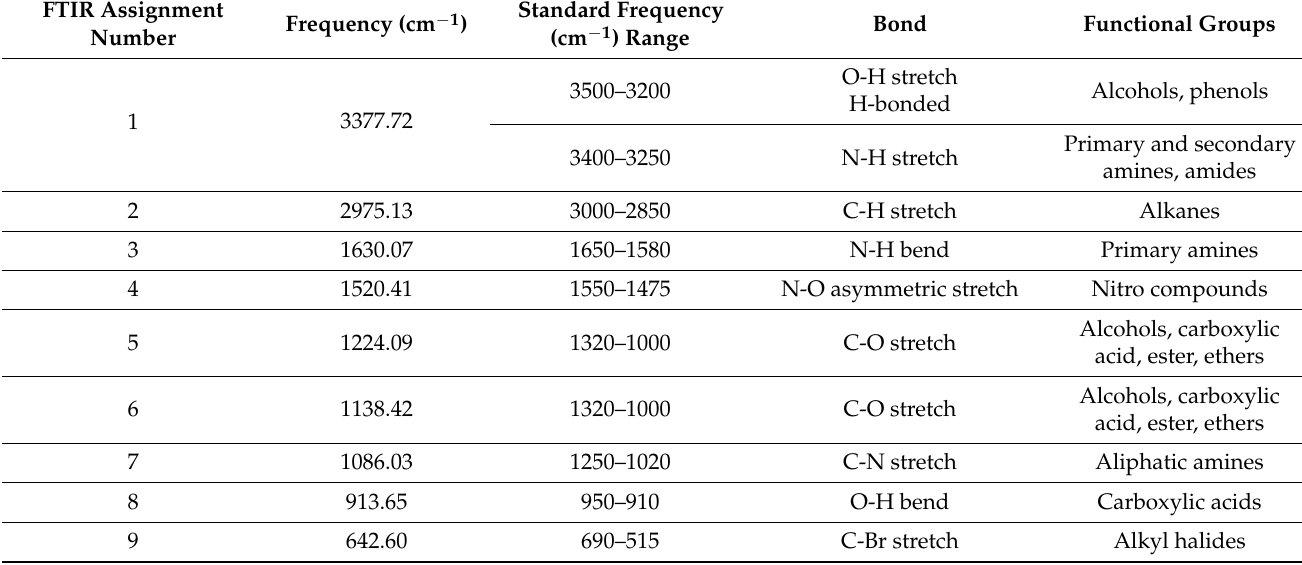
Table 2. FTIR assignments of functional groups observed in TPE-mediated ZnO NPs.